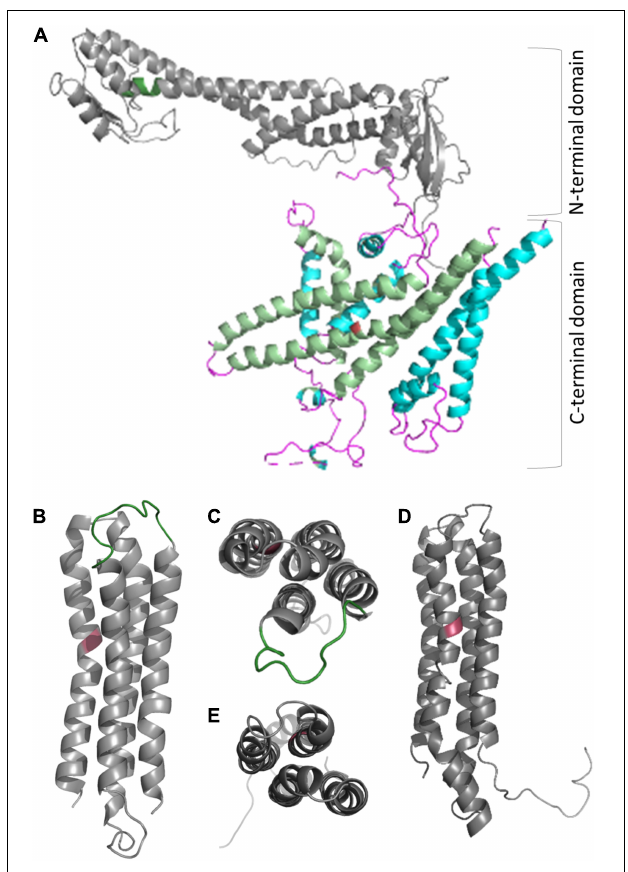
FIGURE 3 | Structure of proteolipids VHA-c and VHA-c” and subunit VHA-a. (A) VHA-a has a bipartite structure of the cytosolic N-terminal domain and the C-terminal membrane integral domain. The N-terminal domain serves as part of stator and bears the TGN localization domain in the case of VHA-a1 (position is indicated by dark green color). Helices of the C-terminal domain form semi-channels for proton loading and unloading of VHA-c (light green helices), and the barrier charge surrounds a conserved arginine residue on helix seven (red colored). (B–D) The proteolipids consist of four transmembrane helices [refer to the view from the cytosolic side: (C,E) ], and the protein binding site is a conserved glutamate residue (red color) located in the fourth helix [VHA-c; (B) ] or the second helix [VHA-c”, (D) ]. A cytosolic loop of VHA-c (green color) serves as a binding site for VHA-d. Structures were obtained with Phyre2 (Kelley et al., 2015), and a complete set of pdb files for A. thaliana VHA subunits is available as Supplementary Data.